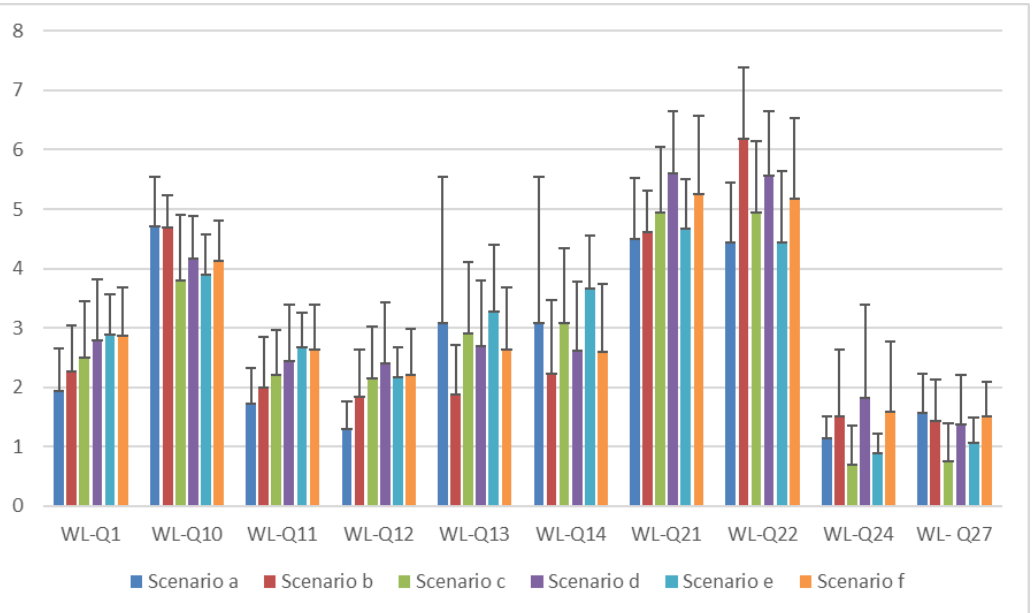
Figure 7. Subjective rating: ATC workload perception on RPAS contingency scenarios compared with baseline scenarios (see questions in Table 7).